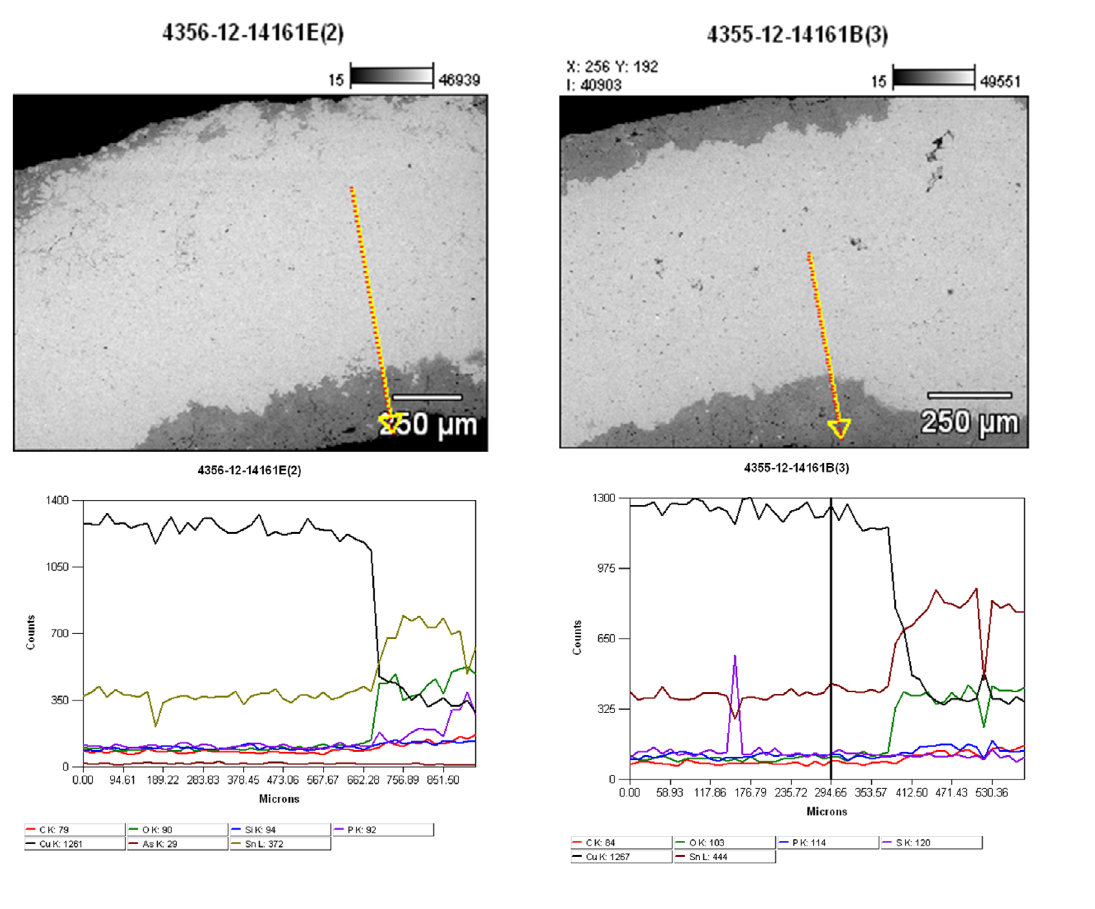
Figure 1. SEM analysis of the specimen sample from the front section and the end plate of the neck collar from Luttmissen, Uelzen (LMN 14161). The element curve clearly shows the change in the elemental values (scan: Dirk Kirchner, German Mining Museum,